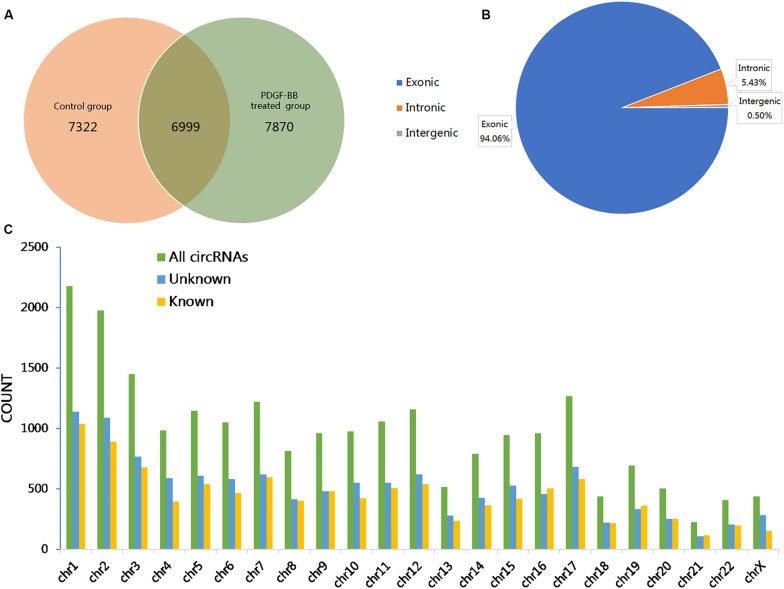
Overview of the identified circular RNAs (circRNAs) in PDGF-BB-treated VSMCs (PS) and controls (NC). (A) The Venn diagram shows the number of unique and common circRNAs in PS and NC. (B) The pie chart displays the ratio of circRNAs originating from exonic, intronic, and intergenic regions. (C) Chromosomal distribution of all identified circRNAs.